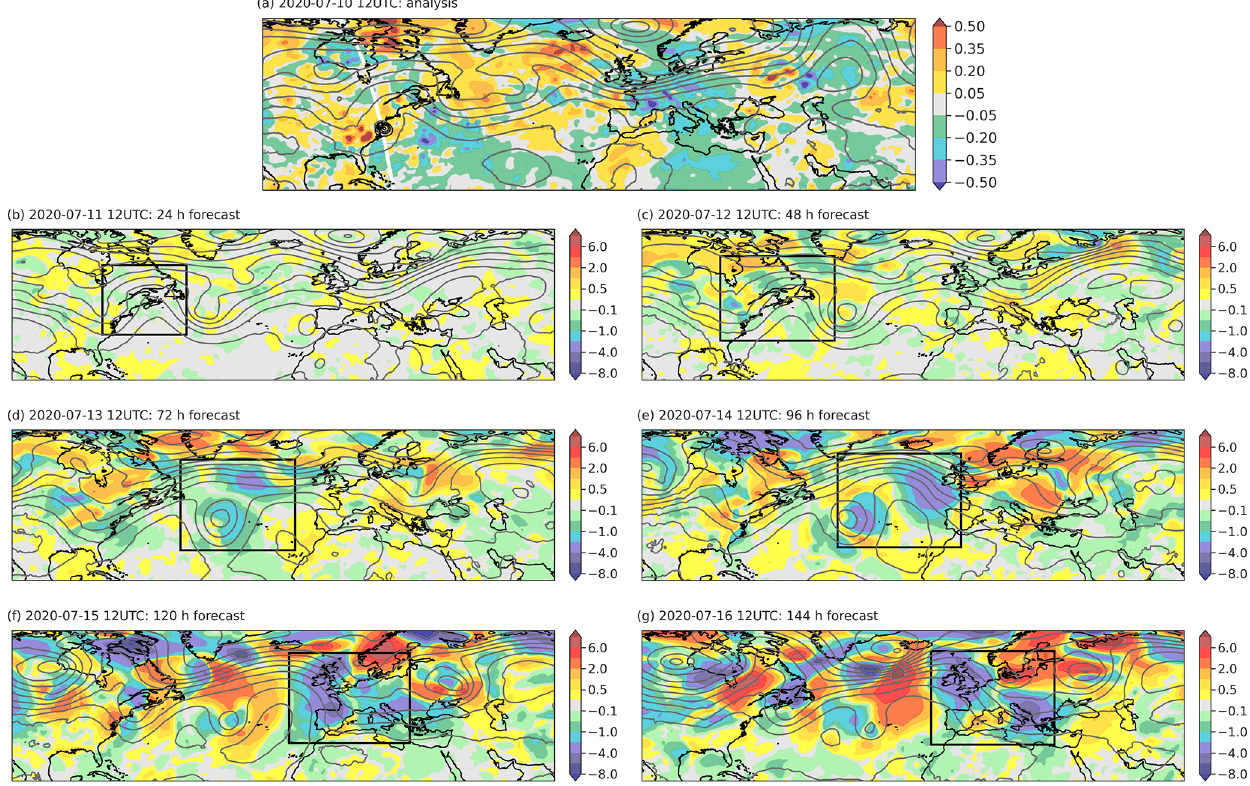
Figure 7. Downstream impact of Aeolus at 500hPa geopotential from forecast start on 10 July 2020 at 12:00UTC for the region (20–70 ◦ N, 110 ◦ W–70 ◦ E). (a) Differences in analysis between EXP_A and CTRL for 10 July 2020 at 12:00UTC: the white line is the Aeolus track; the black contours are the minimum surface pressure. (b) Differences in 24h forecast error (EXP_A − CTRL) for 11 July 2020 at 12:00UTC. (c) Differences in 48h forecast error for 12 July 2020 at 12:00UTC. (d) Differences in 72h forecast error for 13 July 2020 at 12:00UTC. (e) Differences in 96h forecast error for 14 July 2020 at 12:00UTC. (f) Differences in 120h forecast error for 15 July 2020 at 12:00UTC. (g) Differences in 144h forecast error for 16 July 2020 at 12:00UTC. The box highlights the area of interest associated with the ET event; the grey contour lines represent the 500hPa geopotential from the ERA5 reanalysis in 5gpdm (geopotential decameter) steps.